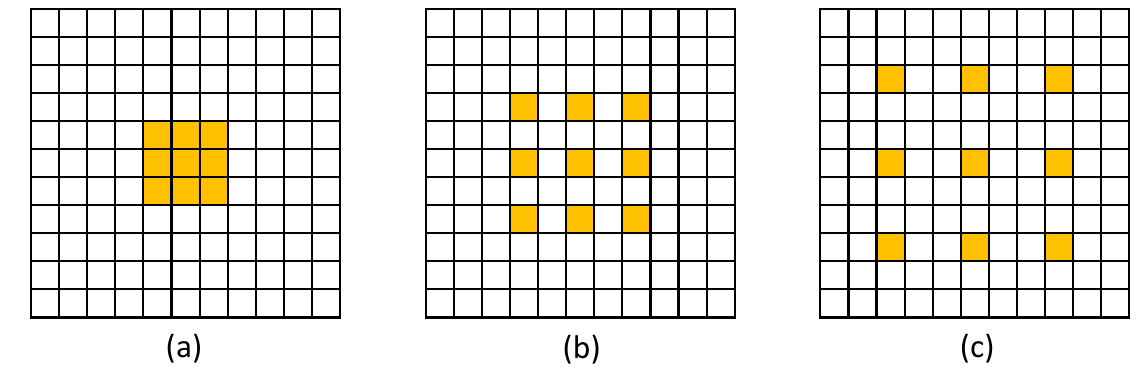
Figure 4. Diagram of dilated convolution. The size of the convolution kernel is 3 × 3 and the dilation ratio is 1, 2, and 3, respectively. ( a ) Convolution with dilation ratio of 1; ( b ) Convolution with dilation ratio of 2; ( c ) Convolution with dilation ratio of 3.